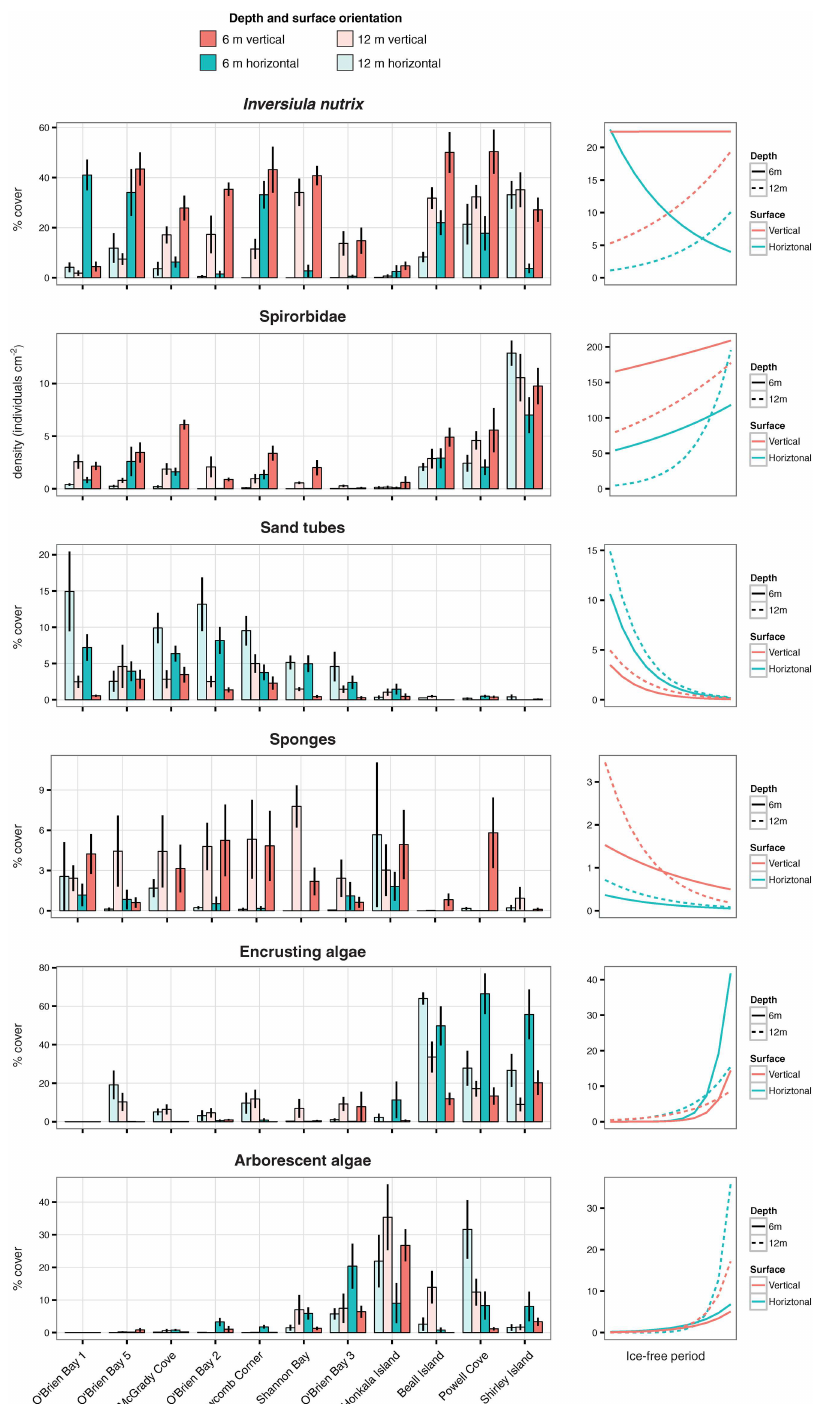
Fig 6. Percentage cover or density of dominant taxa and groups. Left-hand plots show data from all sites, depths and orientations. Bars show the mean value, and error bars show standarderror. Right-hand plots show predicted values of significanteffects detected by